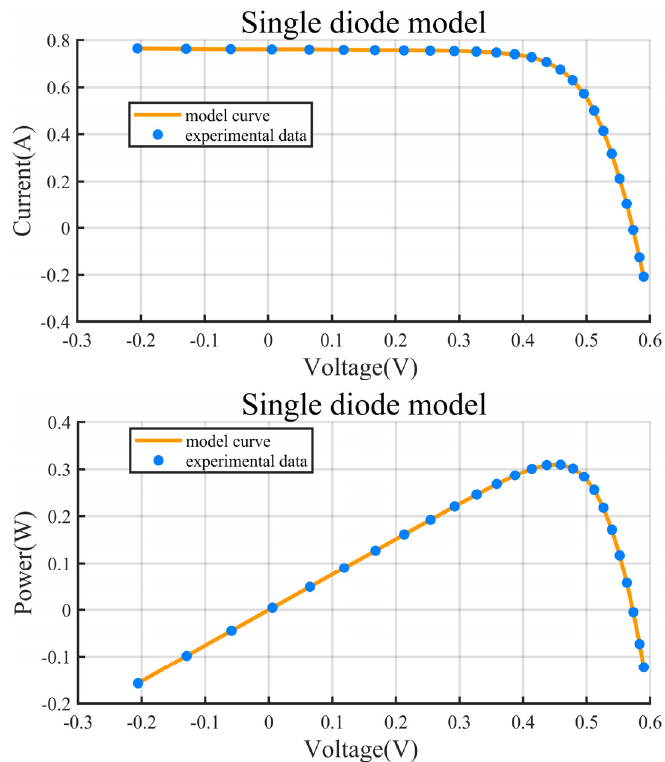
Figure A1. Comparisons between the experimental data and simulated data obtained by IMFO for single diode model: I ‐ V and P ‐ V characteristics.